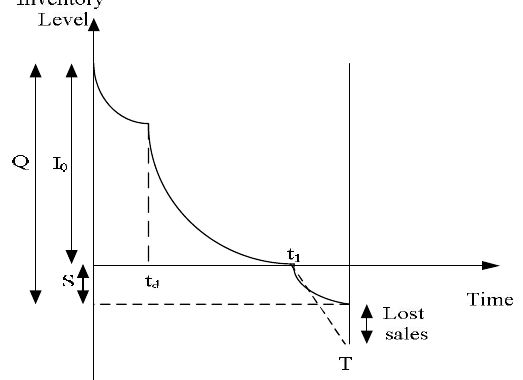
Fig. 1. Graphical representation of the inventory